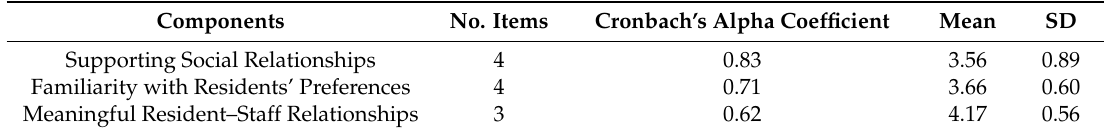
Table 5. Cronbach’s Alpha Coefficient and Descriptive